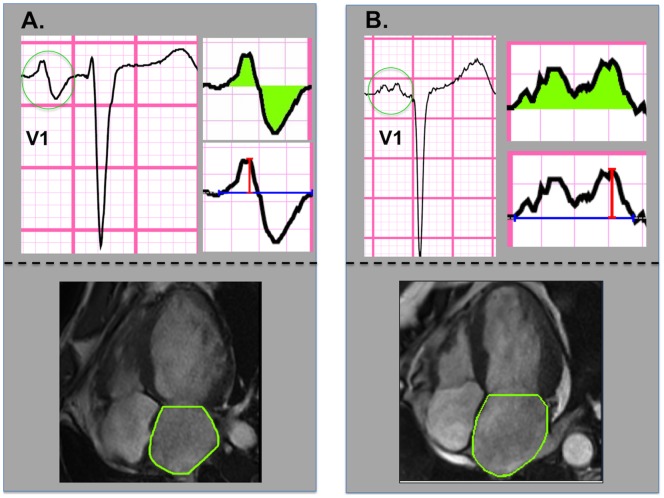
P wave and Left Atrial Area Quantification.Representative examples of LA quantification methods: For ECG (top), total P wave area was quantified based on geometric area (green shading) between the electrical waveform and the isoelectric line. Corresponding indices of amplitude (red line) and duration (blue line) were measured within the total P wave complex, as well as its positive and negative components. For CMR (bottom), LA area was measured by planimetry of chamber borders (green line) at ventricular end-systole. Note heterogeneity in P wave morphology among patients with LA enlargement: Whereas both patient examples demonstrate LA dilation by CMR, a bimodal P wave with large negative terminal component is present in 1A, whereas a bifid but upright P wave is present in 1B.